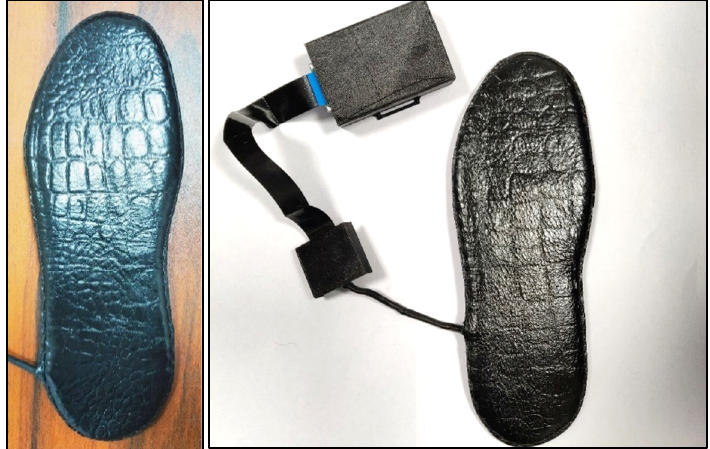
Figure 7. Complete device assembly.